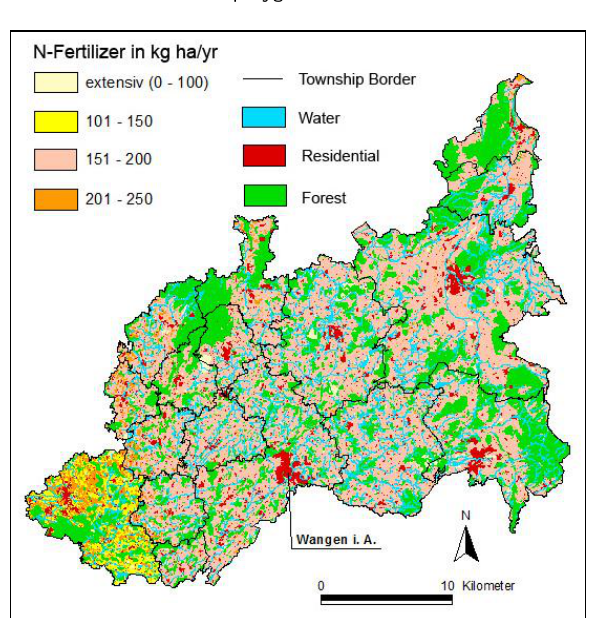
Figure 3. Spatially disaggregated regionalization of N-fertilizer input for the “Württembergisches